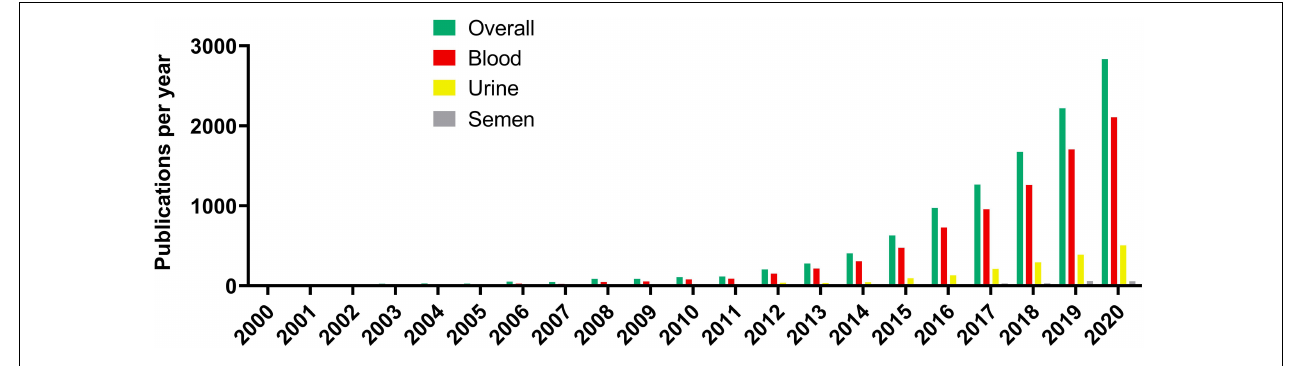
FIGURE 1 | Cell-free DNA article publication rate per